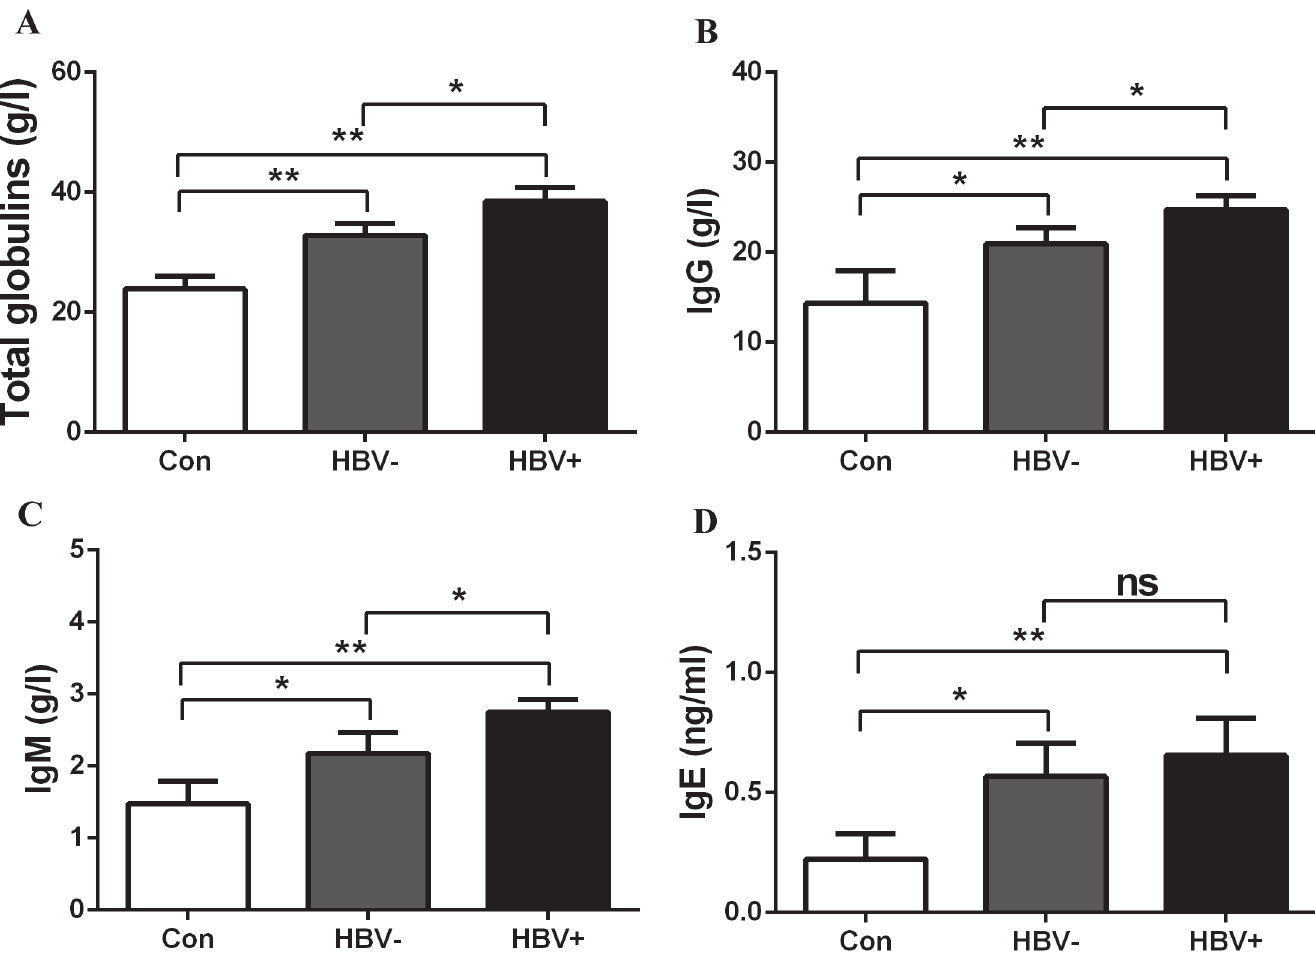
Fig 1. Increased levels of immunoglobulin were present in HCC patients with or without chronic hepatitis B virus infection. The levels of total immunoglobulin, IgG, IgM, IgE were evaluated in healthy controls, HBV- (HBV-negative) and HBV+ (HBV-positive) patients. * p < 0.05, ** p < 0.01, ns, no